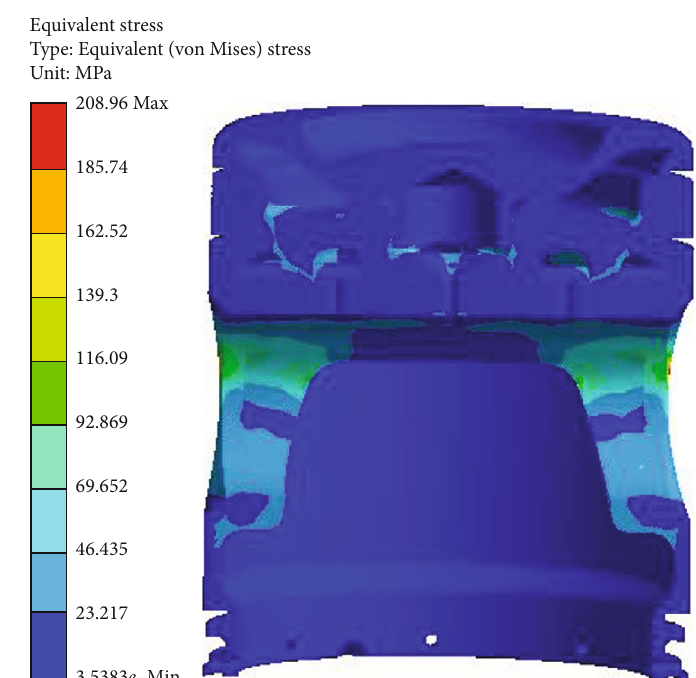
Figure 8: The von Mises stress nephogram of the piston under mechanical stress